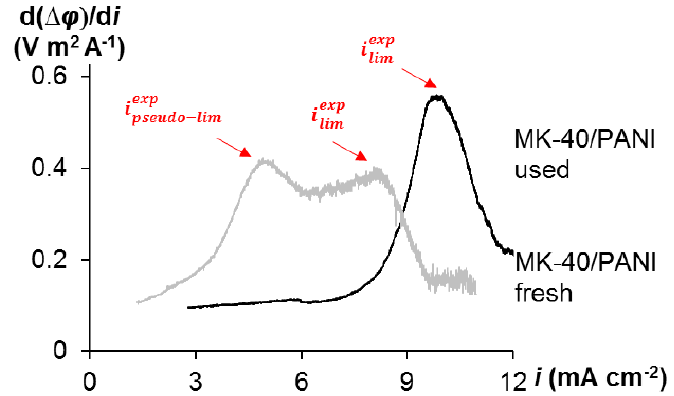
Figure 4. Derived I-V curves, d( ∆ φ )/d i , for fresh and used MK-40/PANI membranes.